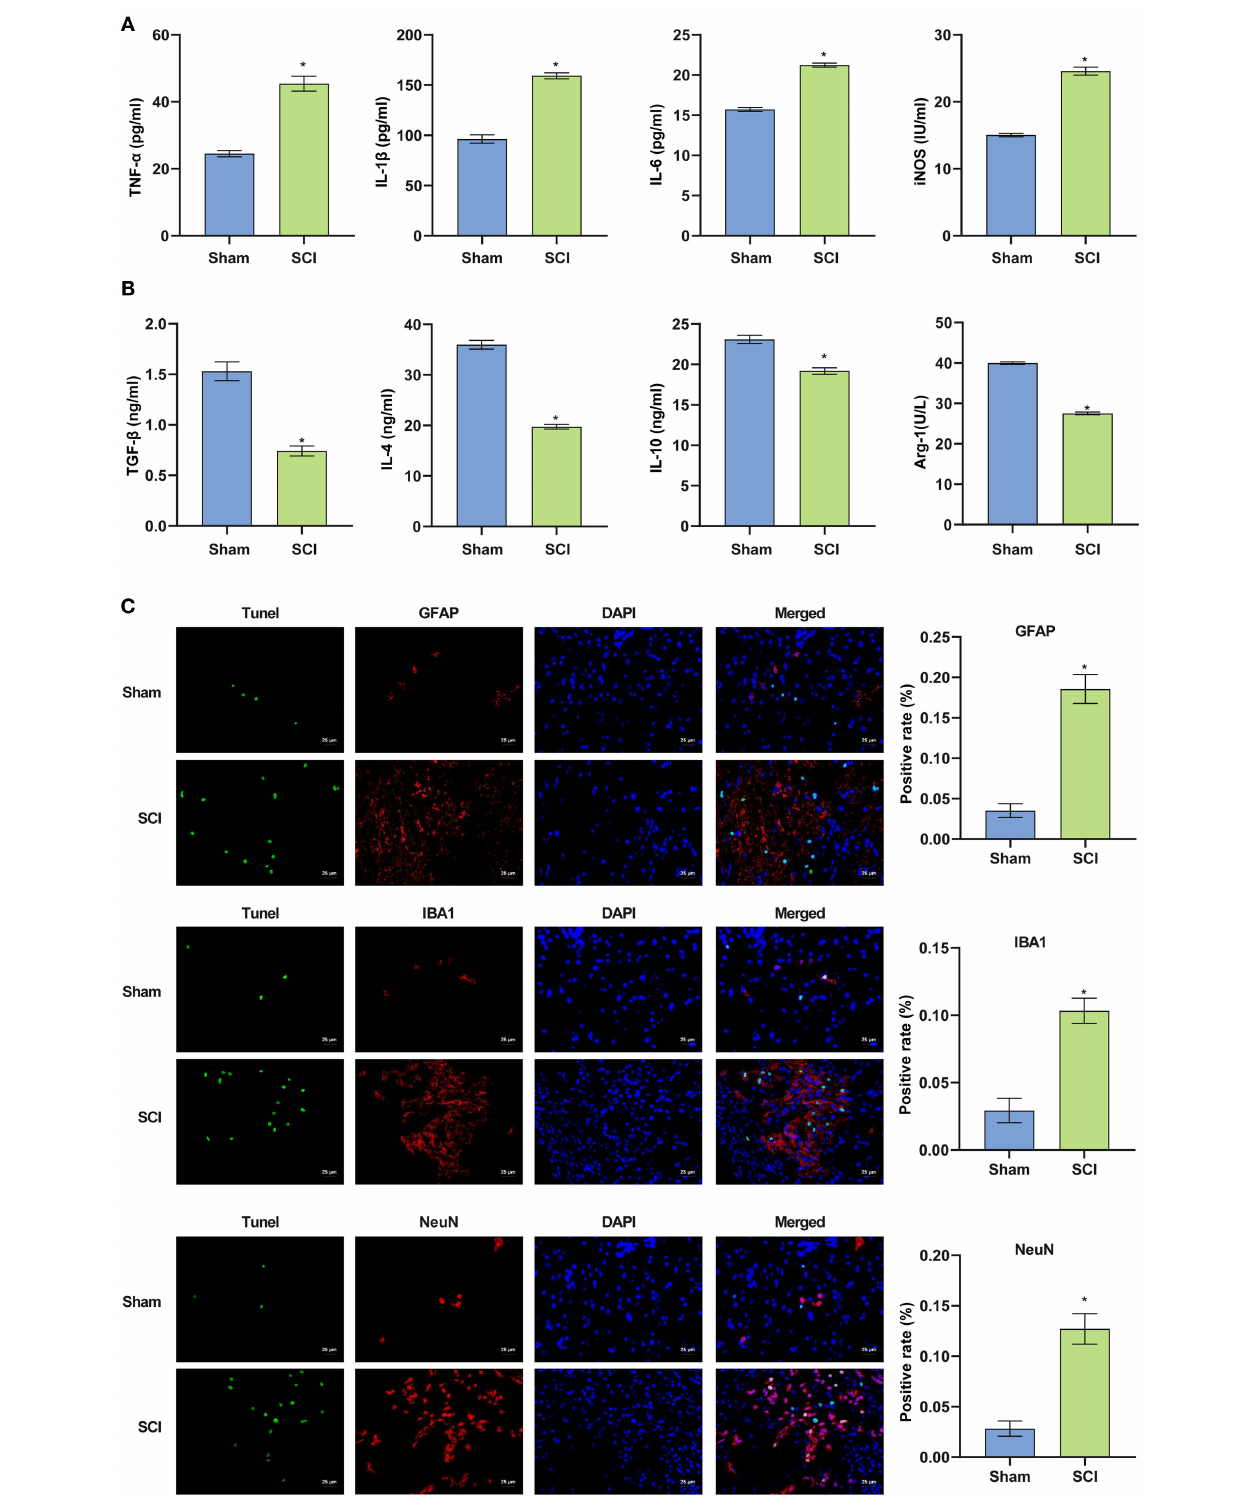
FIGURE 3 | The successful construction of the SCI mouse model. (A,B) Pro-inflammatory factors were increased in SCI mice and anti-inflammatory factors were decreased. (C) Terminal deoxynucleotidyl transferase dUTP nick end labeling assay was used to detect cell apoptosis in the spinal cord of mice (Scale bar = 25 µ m). * P < 0.05 compared with Sham group. The unpaired t-test was used to analyze comparisons between two groups n = 5.